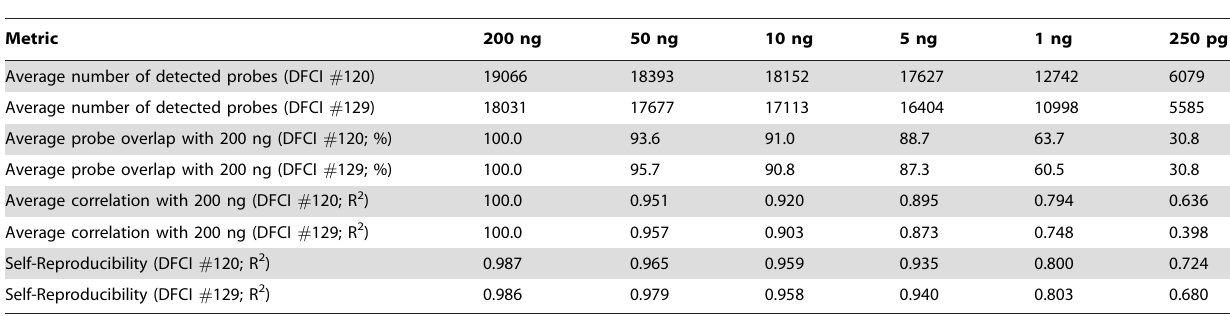
Table 1. WG-DASL Assay Performance as a Function of FFPE RNA Input.